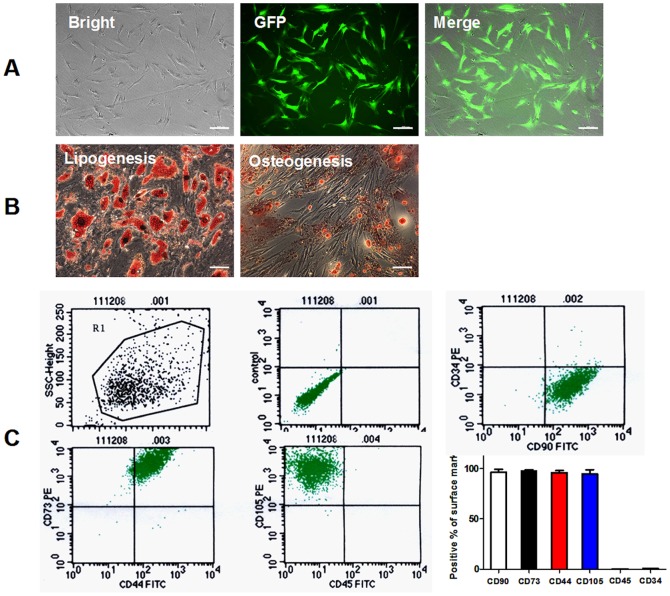
Characterization of human ADSCs and GFP labeling.A: Representative images of ADSCs transfected with lentiviral GFP. ADSCs showed fibroblast-like morphology and genetically labeled with GFP. B: Lipogenenic and Osteogenic differentiation of ADSCs lentivirally labeled with GFP. Histochemical staining of adipocytes (oil red O, left panel) and osteocytes (Alizarin red, right panel). C: Flow cytometric analysis shows that human ADSCs were positive for CD90, CD73, CD44 and CD105 and negative for CD34 and CD45. ADSC: adipose-derived mesenchymal stem cells. GFP: green fluorescent protein.